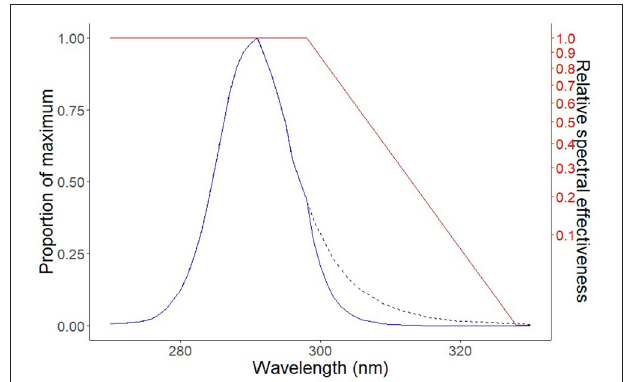
FIGURE 1 | The figure presents the output wavelength curve of the UV light-emitting diode (LED) device and demonstrates the effectiveness of the UV source to produce erythema. The diagram of the spectral output of the UV LED device (black dashed line), the spectral output of the UV LED device weighted by the International Commission on Illumination (CIE) action spectrum (solid blue line), and the CIE action spectrum of human erythema (solid red line) (5).